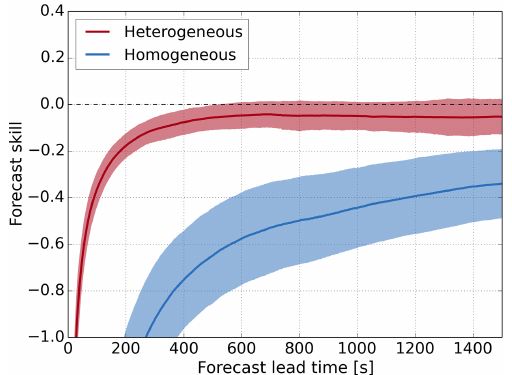
Figure 10. Average RMSE of all stations depending on the forecast horizon and the predominant cloud conditions. Solid lines repre- sent the sky imager forecasts, while dashed lines show persistence errors.